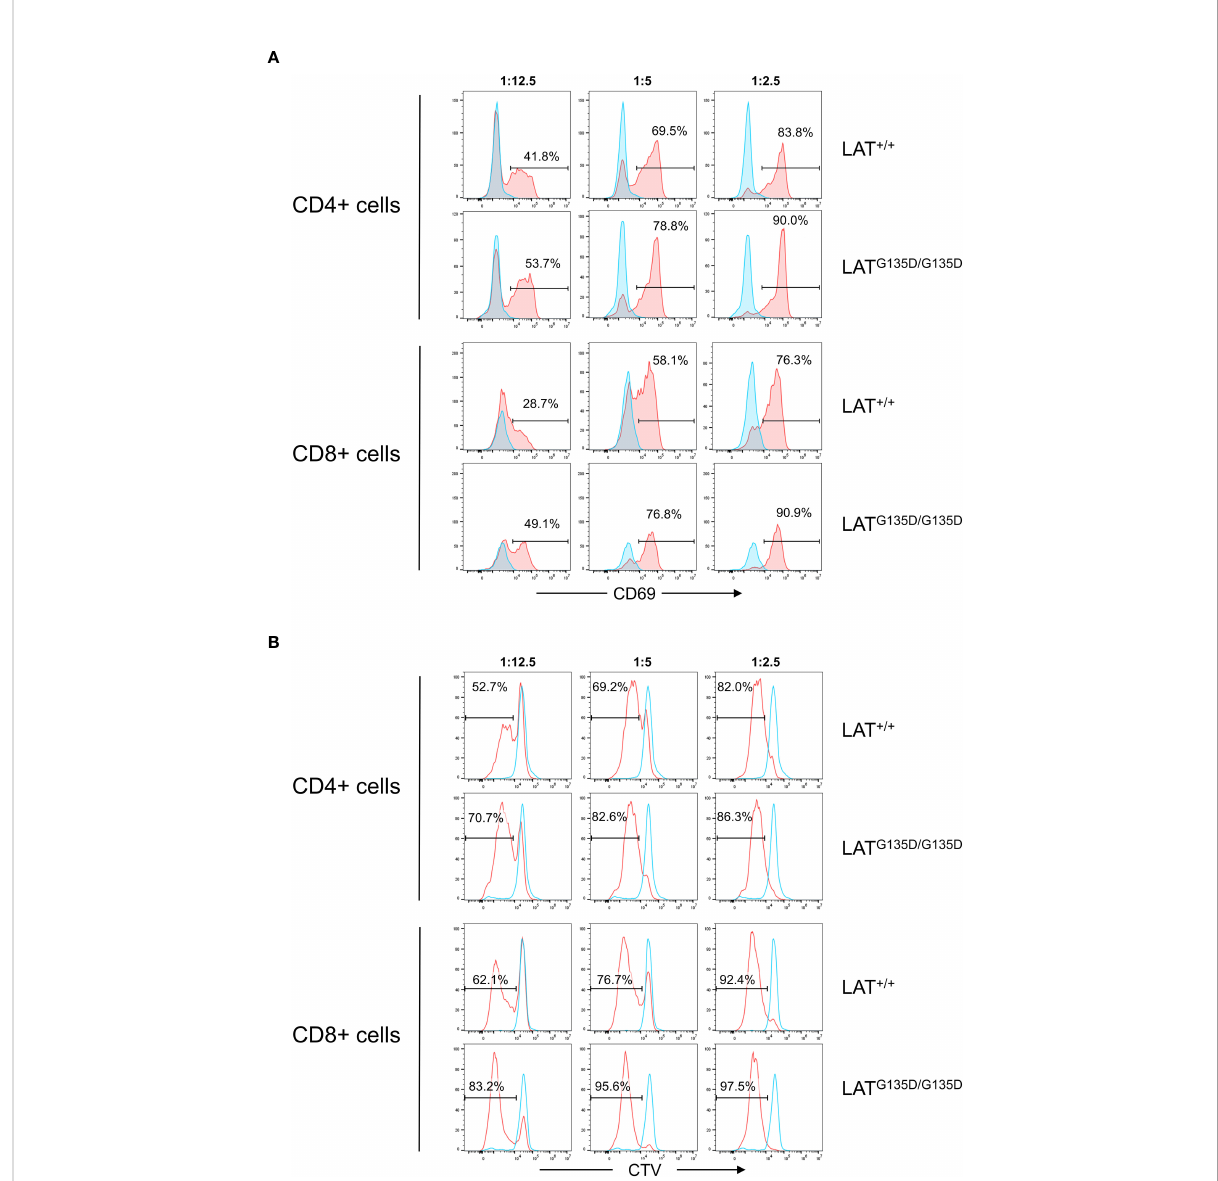
FIGURE 4 Ex vivo stimulation assays. (A) T cells puri fi ed from the spleens of wild-type LAT (LAT +/+ ) and homozygous (LAT G135D/G135D ) mutant mice were stimulated with the indicated bead:cell ratios of anti-CD3/CD28 microbeads, and analysis of CD69 surface expression 24H post-stimulation was performed on live cells (Annexin V negative). CD69 expression in CD4+ and CD8+ cell populations are shown separately. The numbers indicated in each histogram represent the percentage of CD69 positive cells (red histograms). Blue histograms show CD69 expression in unstimulated cells. One representative experiment is shown (n=3). (B) Analysis of proliferation performed at 72H post-stimulation. Decrease of CTV staining indicates cell proliferation. Blue histograms correspond to unstimulated cells and red histograms to anti-CD3/CD28 stimulated cells. Proliferative capacity was analyzed separately in CD4+ and CD8+ cell populations. The numbers shown in each histogram represent the percentage of cells that have proliferated. One representative experiment is shown